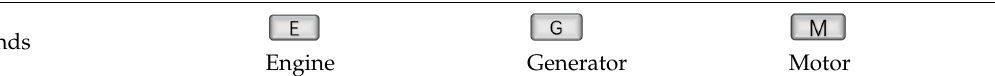
Table 3. Characteristics and applications of combined hybrid configurations [15–18].